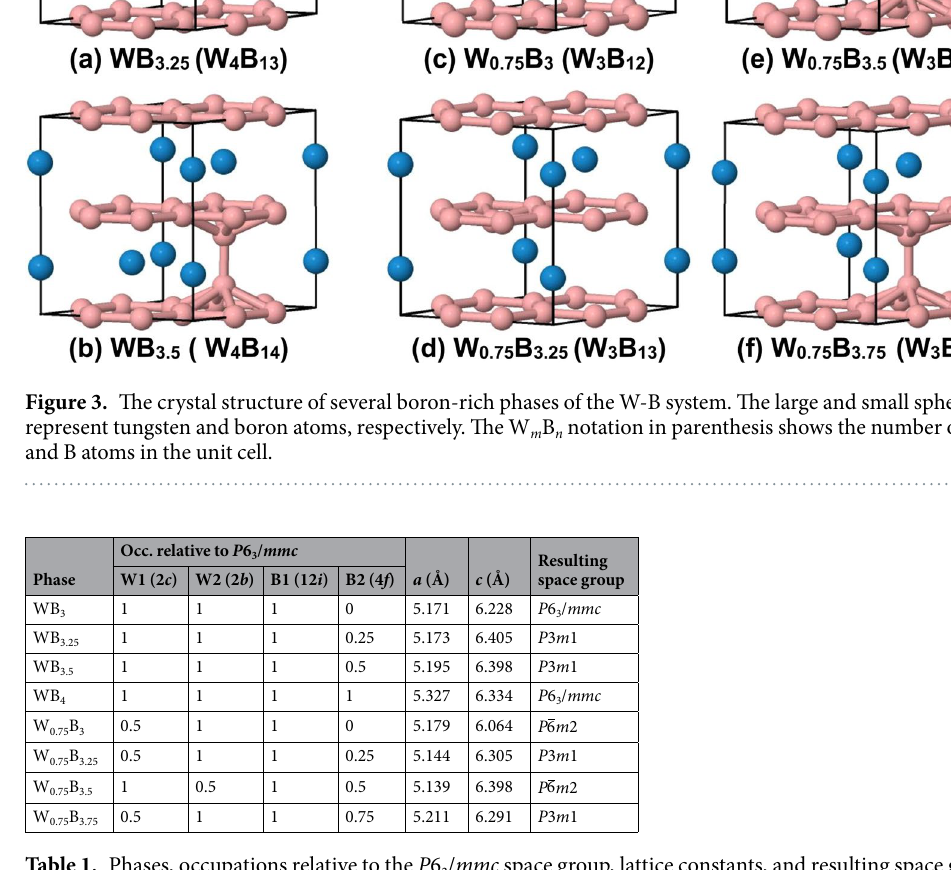
Table 1. Phases, occupations relative to the P 6 3 / mmc space group, lattice constants, and resulting space groups of the most stable structures at a given boron atomic